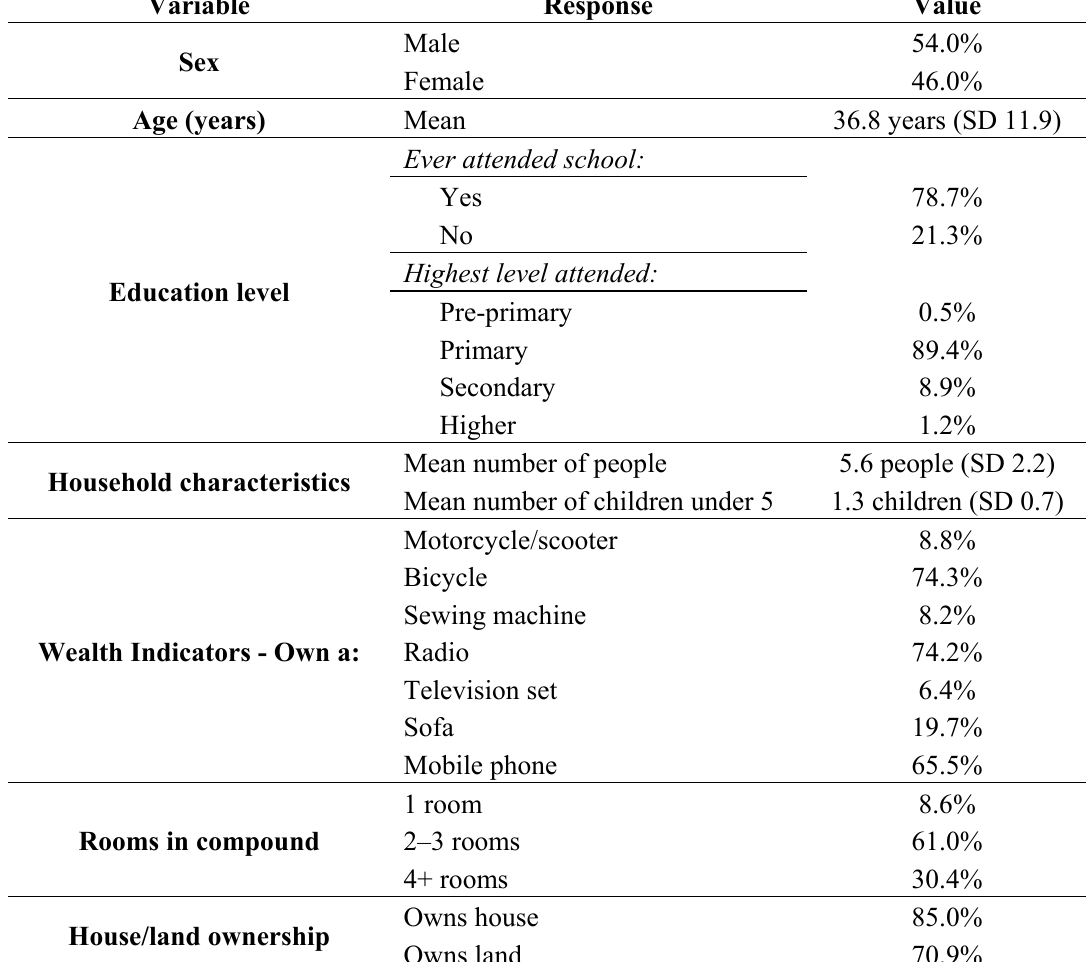
Table 1. Demographics of survey